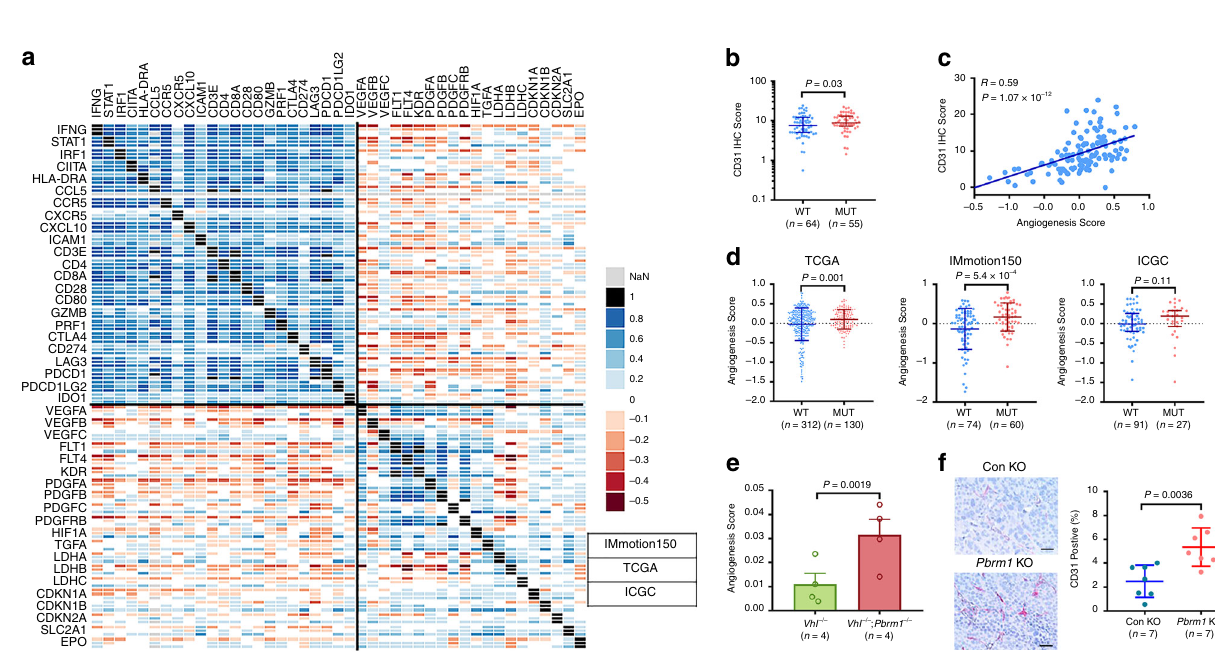
Fig. 5 Loss of PBRM1 function was associated with increased angiogenesis. a Correlogram between the expression of immunomodulatory and angiogenic genes IMmotion 150 cohort (top line of each square), TCGA cohort (middle line of each square) and ICGC cohort (bottom line of each square). b Patients with mutant PBRM1 demonstrated increased CD31 immunostaining levels in the IMmotion150 cohort. Rank-sum test. c CD31 immunostaining levels positively correlated with angiogenesis expression score. Spearman correlation and associated P -value inset ( N = 119). d PBRM1 mutated tumors were associated with increased angiogenesis score in 3 indicated patient cohorts. Rank-sum test. e Pbrm1 knockout was associated with increased angiogenesis score in pre-malignant murine kidneys. Student t -test. f Pbrm1 knockout Renca tumors demonstrated increased CD31 immunostaining levels. Student t -test. Data in the bar graphs represent mean ± S.D. Source data are provided as a Source Data fi (Fig. 6a, Supplementary Fig. 5A). When comparing the changes with or without treatment, anti-PD-1 treatment provided more signi fi cant survival bene fi t and tumor growth control in mice bearing control knockout tumors than in those with Pbrm1 knockout tumors (Fig. 6a, Supplementary Fig. 5A). Our Renca subcutaneous tumor model con fi rmed that PBRM1 inactivation slowed tumor progression, while Pbrm1 knockout tumors were more resistant to early treatment with PD-1 antibody. We then assessed response to a delayed anti-PD-1 regimen, in which anti-PD-1 treatment was initiated when tumors reached 100 – 200 mm 3 . PD-1 blockade signi fi cantly reduced tumor growth of control knockout tumors and prolonged survival of mice bearing control knockout tumors, but did not exert signi fi cant changes in mice harboring Pbrm1 knockout tumors (Fig. 6b, Supplementary Fig. 5B). These results further indicate that Pbrm1